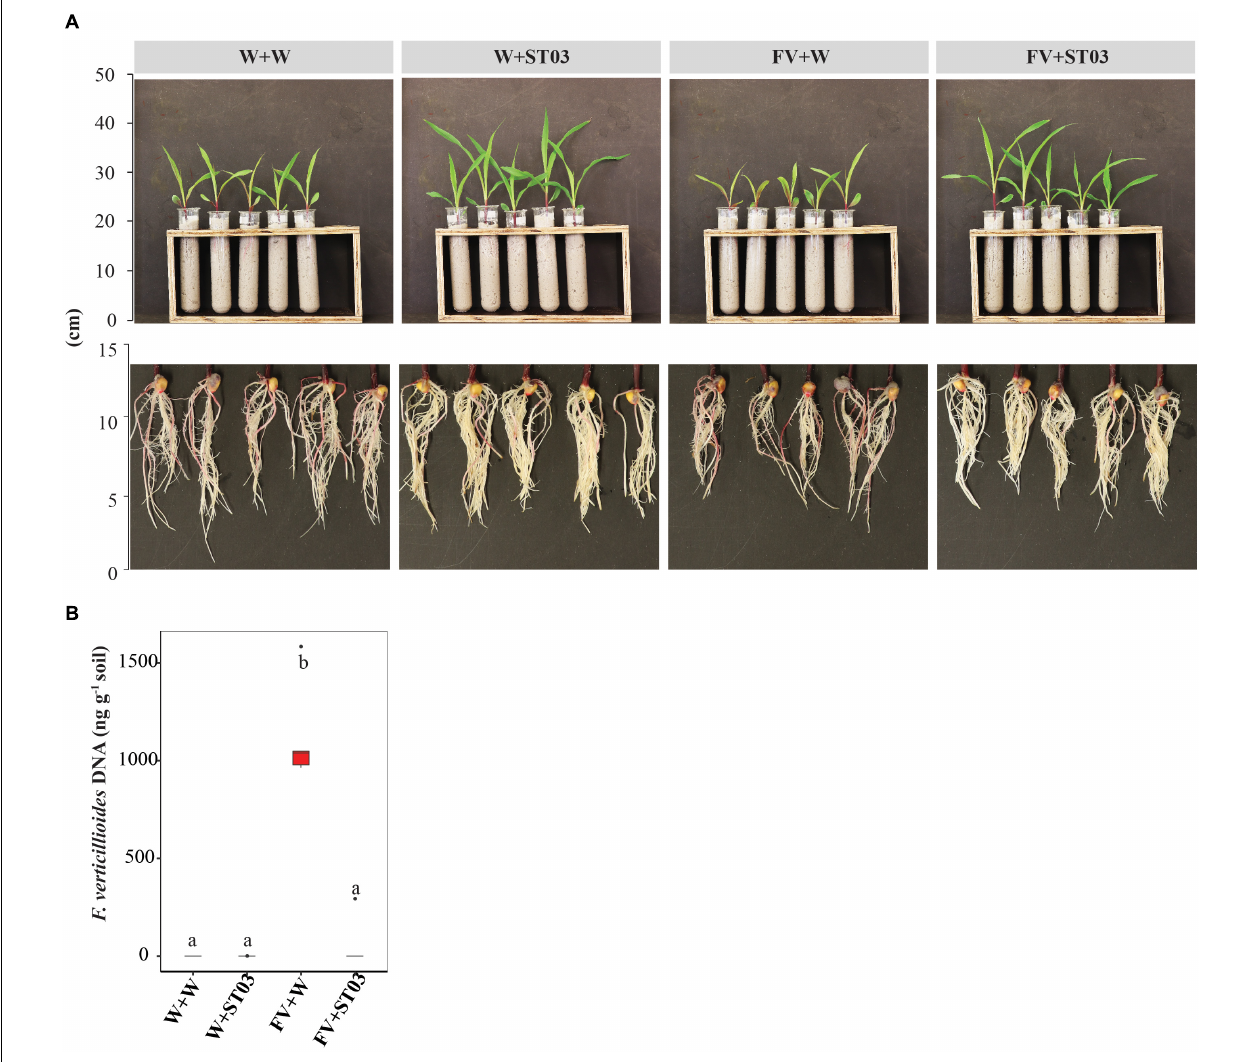
FIGURE 4 | In vivo direct antagonism of the Streptomyces strain ST03 on maize seedlings based on levels of Fusarium verticillioides DNA in soil. (A) Plants and roots at 14 days after inoculation. (B) The fungal DNA content (ng g - 1 ) in soil by treatments using a qPCR method. F. verticillioides -infected maize seeds were planted in soil pre-inoculated with the biocontrol strain ST03 (FV + ST03) and planted in soil mock-inoculated with sterile water (FV + W); F. verticillioides non-infected maize seeds were planted in soil pre-inoculated with the biocontrol strain (W + ST03) and planted in mock soil (W + W). A hybrid CP888 maize line was used. Different letters above each box depict the significant difference between treatments using a Kruskal–Wallis test followed by a post hoc Dunn’s test at a significant level of α = 0.05. Five biological replicates were performed per treatment. The experiment was repeated